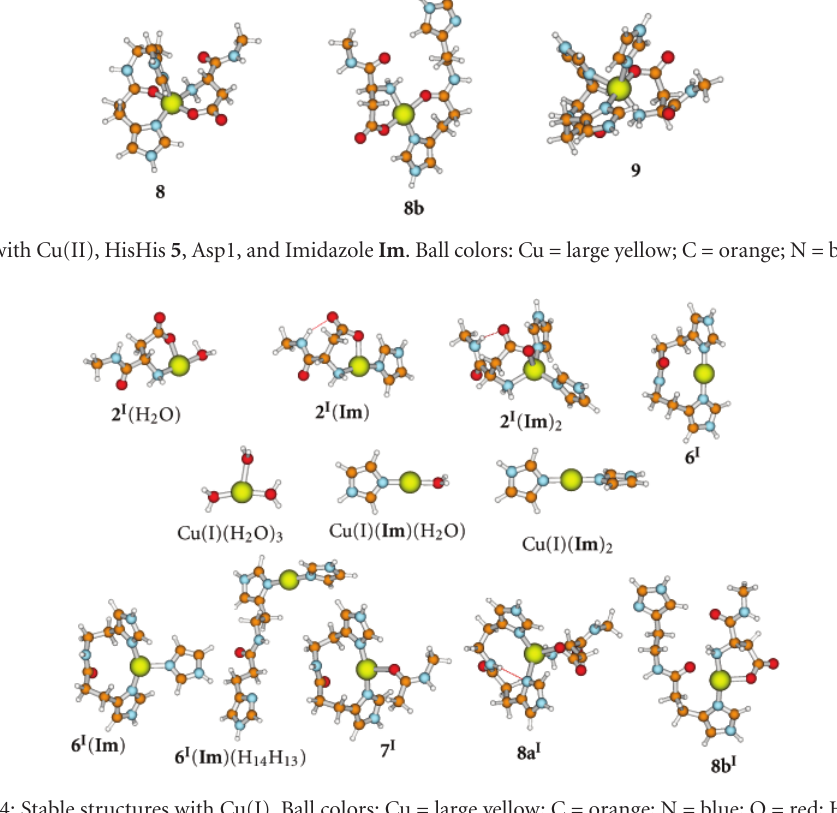
Figure 4: Stable structures with Cu(I). Ball colors: Cu = large yellow; C = orange; N = blue; O = red; H =